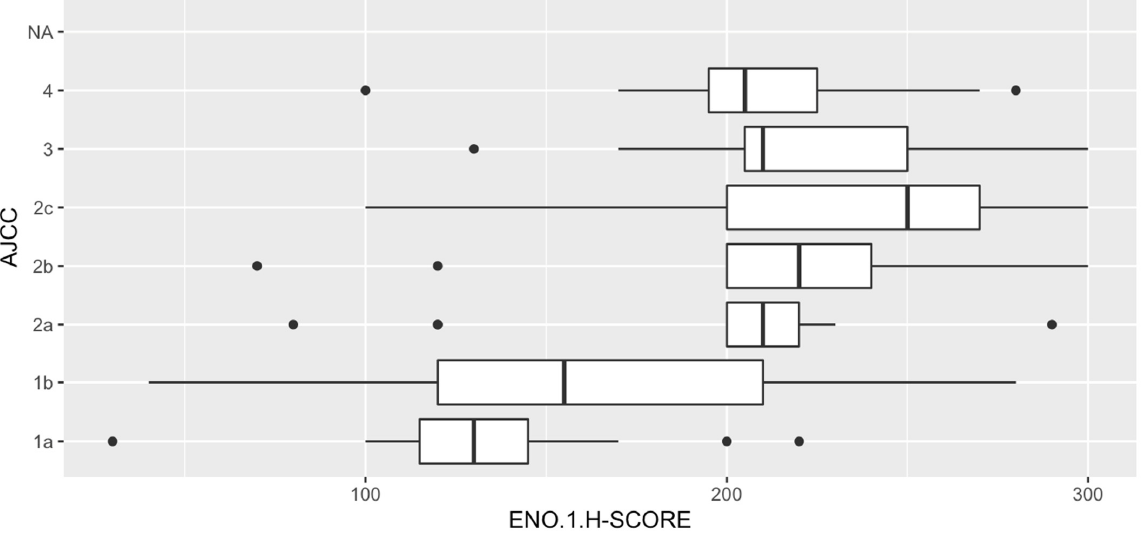
Figure 5. ENO1 expression and AJCC (American Joint Committee on Cancer) staging. The lowest ENO1 expression in tumoral cells was observed in patients with stage I cutaneous melanoma. In stages II-IV, it was observed a significant increasing of ENO1 immunoreactivity in neoplastic cells. Table 1. Correlations between ENO1 expression and clinical parameters of cutaneous melanoma pa- tients. Advanced primary tumors according to Breslow’s and Clark’s scales were character- ized by overexpression of ENO1 ( p < 0.001 for both scales). Furthermore, enhanced ENO1 immunoreactivity in melanoma cells was strongly correlated with high mitotic activity Clinical and presence of ulceration ( p < 0.001, and p = 0.013, respectively). High tumoral immuno- logic response was predominantly observed in patients with reduced cytoplasmic ENO1 expression—64% of patients with brisk tumor-infiltrating lymphocytes were